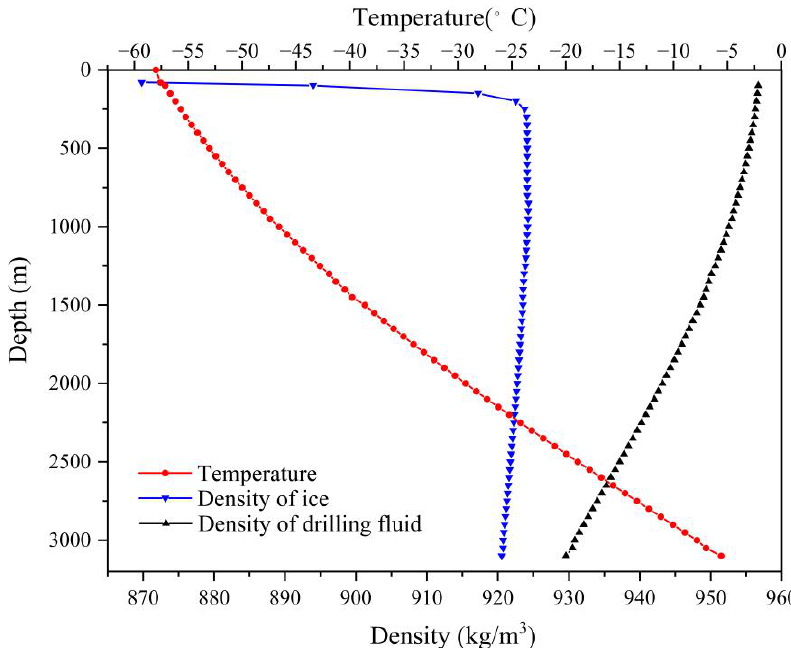
Figure 4. Calculated ice temperature distribution and variation in density with depth at Dome A.